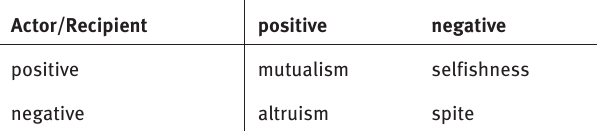
Table 1: Classification of behavior based on the fitness effects of the act for both actor and recipient